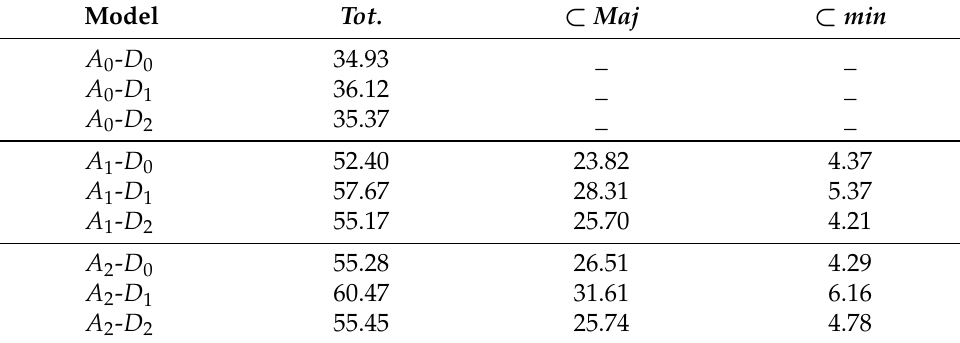
Table 2. Left: total percentage of errors corresponding to inclusions or chord substitution rules, right: percentage of errors with inclusion in the correct triad (% of the total number of errors).